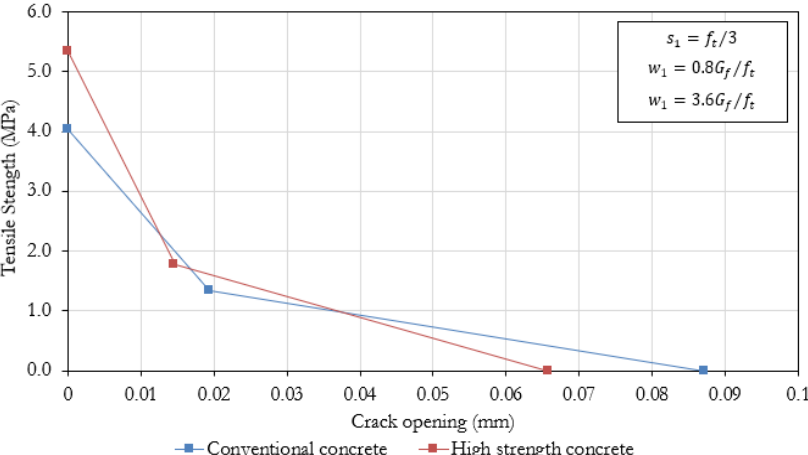
Figure 15. Fracture bilinear mean model for conventional and high strength